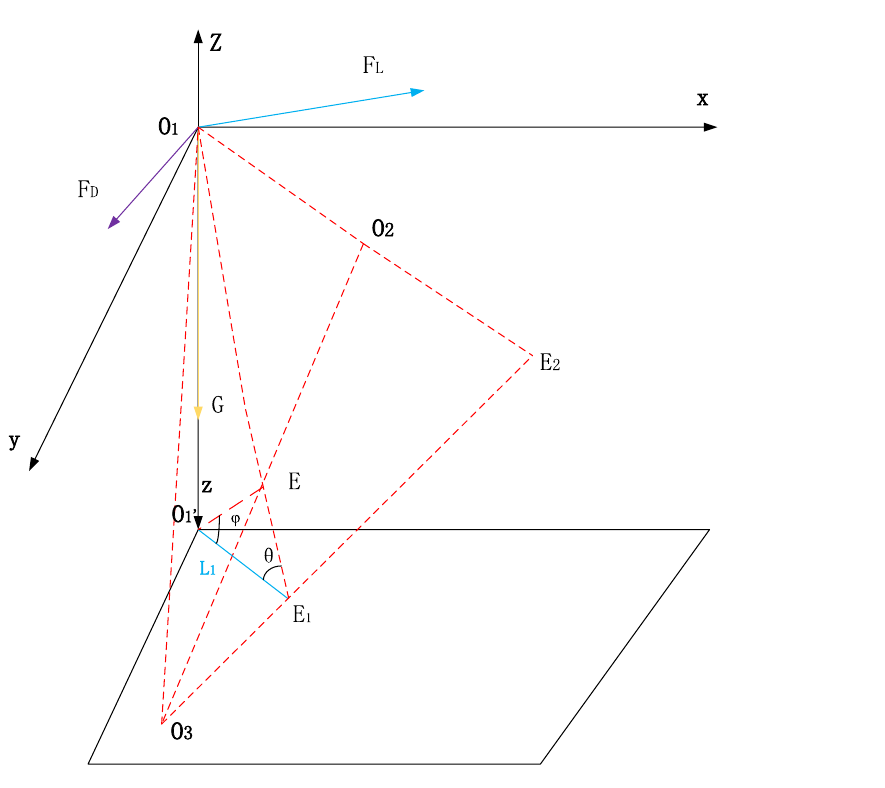
Figure 4. The force analysis diagram of particle O 1